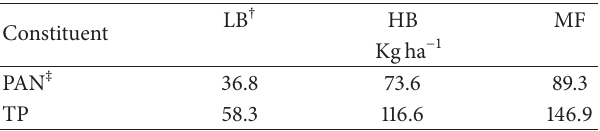
† LB: low rate of biosolids; HB: high rate of biosolids; MF: mineral fertilizer. ‡ For MF, PAN is equal to ammoniacal nitrogen (NH